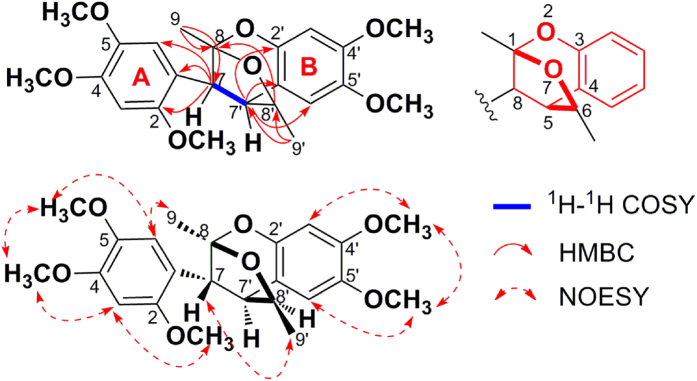
Key 1H−1H COSY, HMBC, and NOESY correlations of 1.